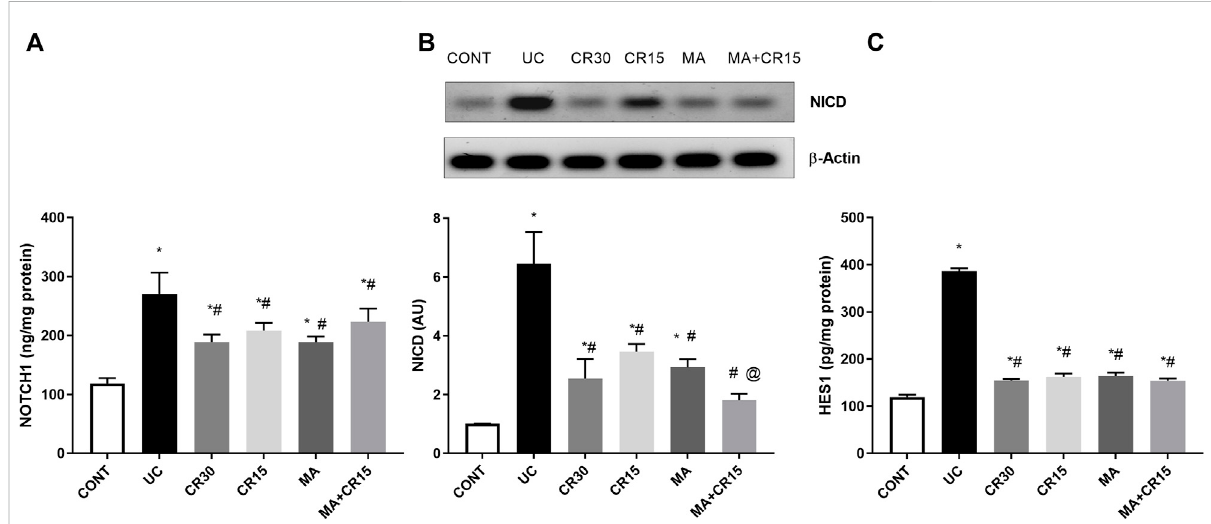
FIGURE 4 Effect of mirabegron and/or carvedilol on colon protein expression/content of (A) NOTCH1, (B) NICD, and (C) HES1 in rats with IAA-induced ulcerative colitis. Data are presented as mean ± SD(n = 4 – 6).Statisticalanalysiswas carried out usingone-wayANOVA followedbyTukey ’ s posthoc test; p < 0.05, as compared to the (*) CONT, (#) UC, and (@) CR15 groups. CONT, control; CR,carvedilol; IA, iodoacetamide;MA, mirabegron; NICD, nuclear intracellular domain; UC, ulcerative